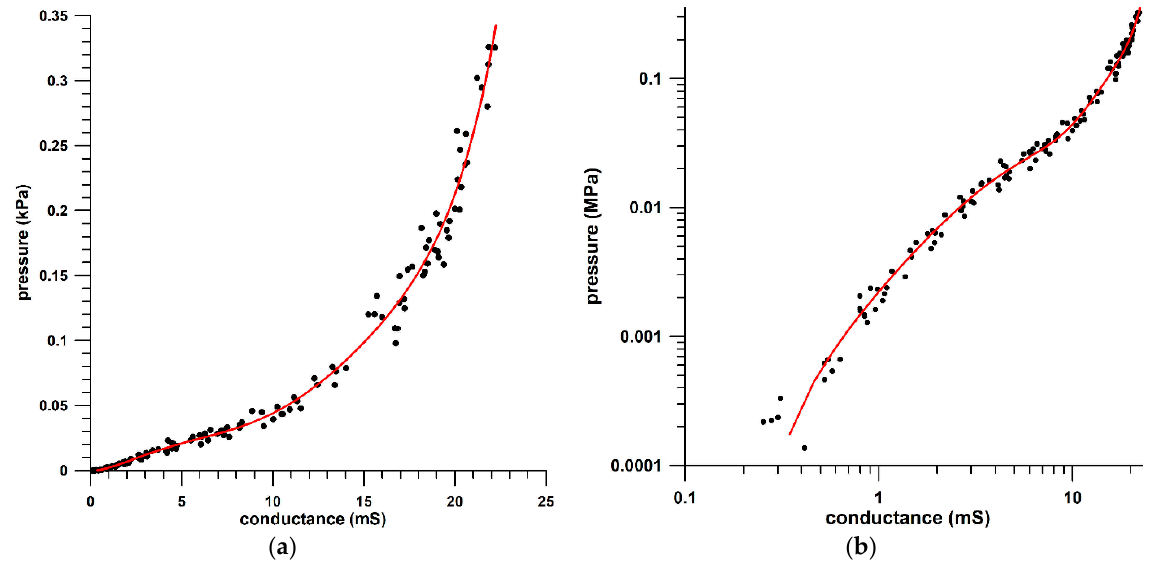
Figure 4. Pressure vs. conductance of the peak data, on Cartesian ( a ) and double-logarithmic ( b ) coordinate systems; the 6th-order polynomial fit line is indicated by the red curve. Although the data are the same in subfigures ( a ) and ( b ), the reason for displaying the data on Cartesian ( a ) and double-logarithmic ( b ) coordinate systems is that the Cartesian coordinate system magnifies large numbers whereas the double-log coordinate systems magnifies small data. To assess the goodness of fit of the function visually across all data, both displays are required.